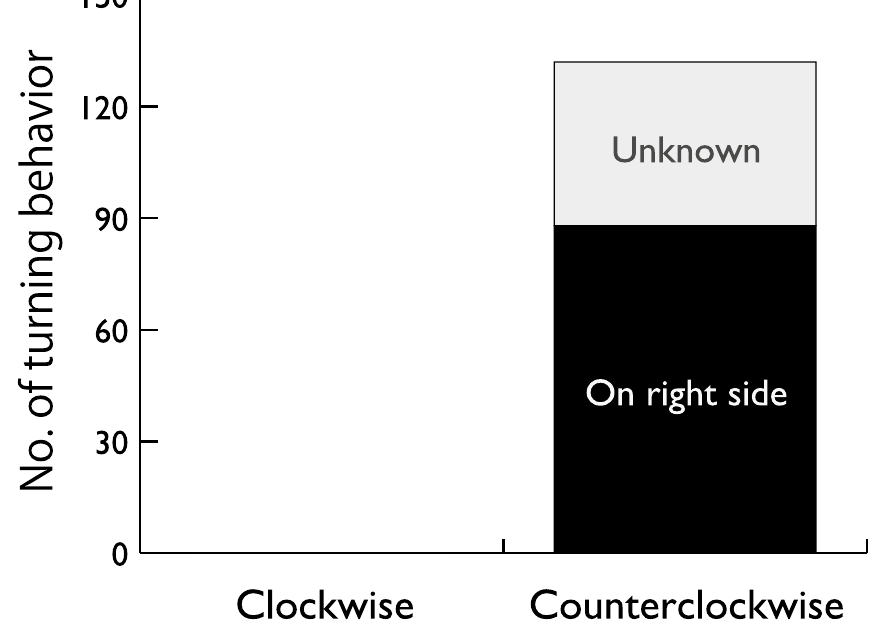
Figure 3. Numbers of clockwise and counterclockwise turning behaviors in finless porpoises noted during aerial observation. Black bars represent the number of observations in which the porpoises turned on their right side. No other postures were